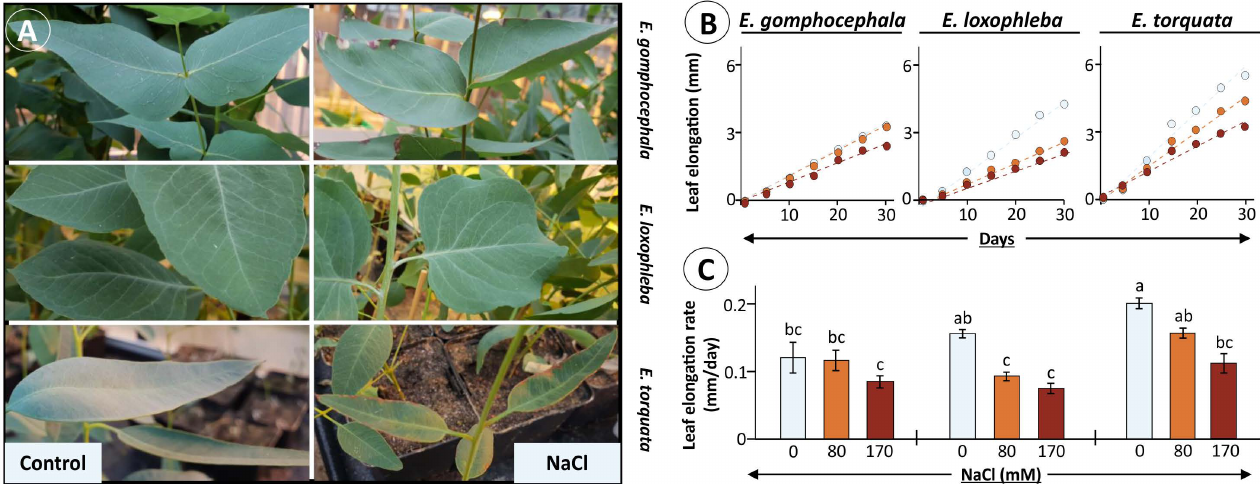
Figure 1. Leaf growth phenotype for Eucalyptus species under salt stress. Selected Eucalyptus species were exposed to increasing amounts of NaCl (0, 80 and 170 mM) and observed for leaf growth rates during 30 d of treatment. ( A ) Leaf phenotype as photographed after 30 d of maximum salt exposure to 170 mM. Measured leaf elongation presented as a growth-time curve ( B ) during treatment period along with calculated leaf elongation rate per day ( C ) for each species. Data for elongation rate per day ( C ) are means ± SE ( n = 8, p < 0.05; ANOVA and Tukey’s post-hoc test).